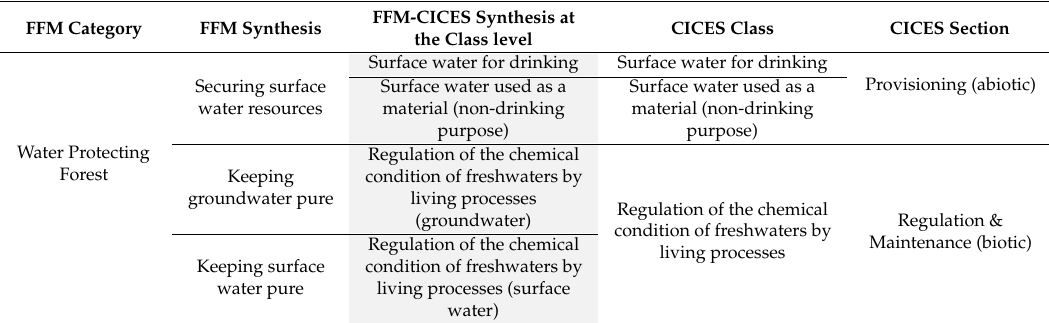
Table 2. Deriving a synthesis between FFM Synthesis and CICES at Class level. Source: own representation. Grey-shaded cells contain a synthesis between CICES Class and German FFM terminology, due to a complementary and more differentiated level of information in either FFM or